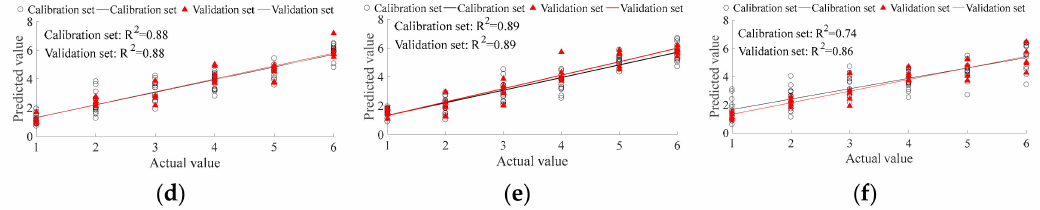
Figure 4. Partial least square regression (PLSR) for ancient Pu’er tea discrimination based on E-nose. ( a – c ) are traditional feature extraction; ( d – f ) are CNN feature extraction; ( a , d ) are E-nose detection; ( b , e ) are VIS / NIR spectrometer detection; and, ( c , f ) are multi-information fusion detection.